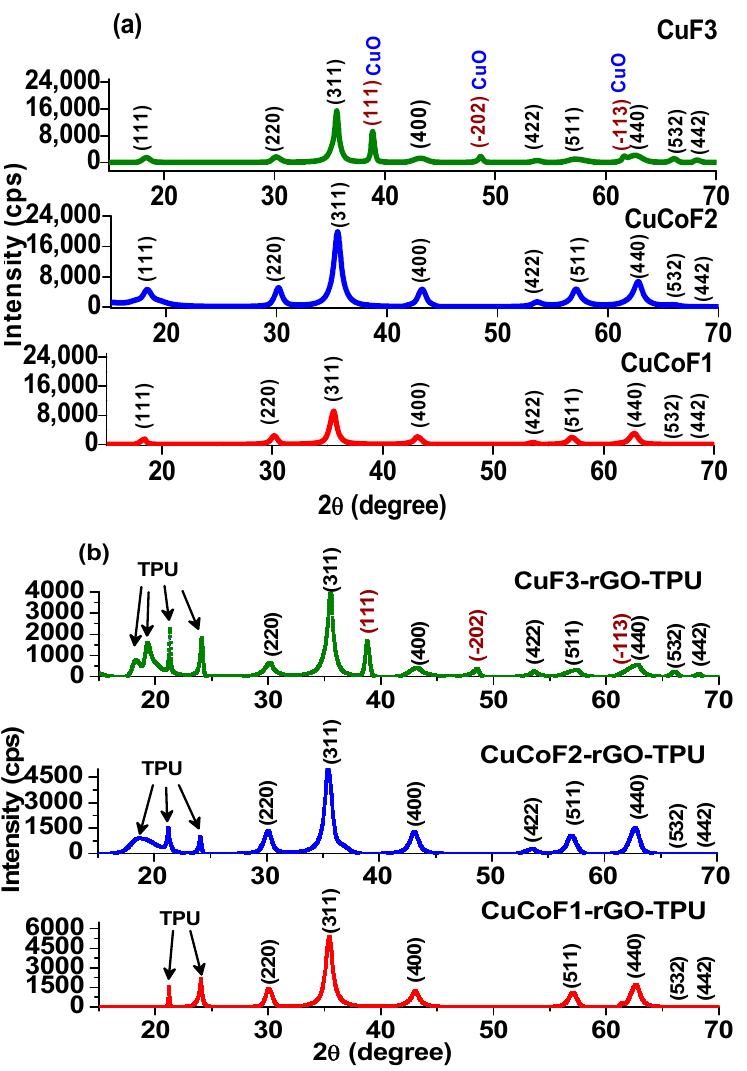
Figure 1. XRD pattern of ( a ) CuCoF1, CuCoF2 and CuF3 nanoparticles ( b ) nanocomposites CuCoF1, CuCoF2 and CuF3 nanoparticles along with rGO in TPU matrix.